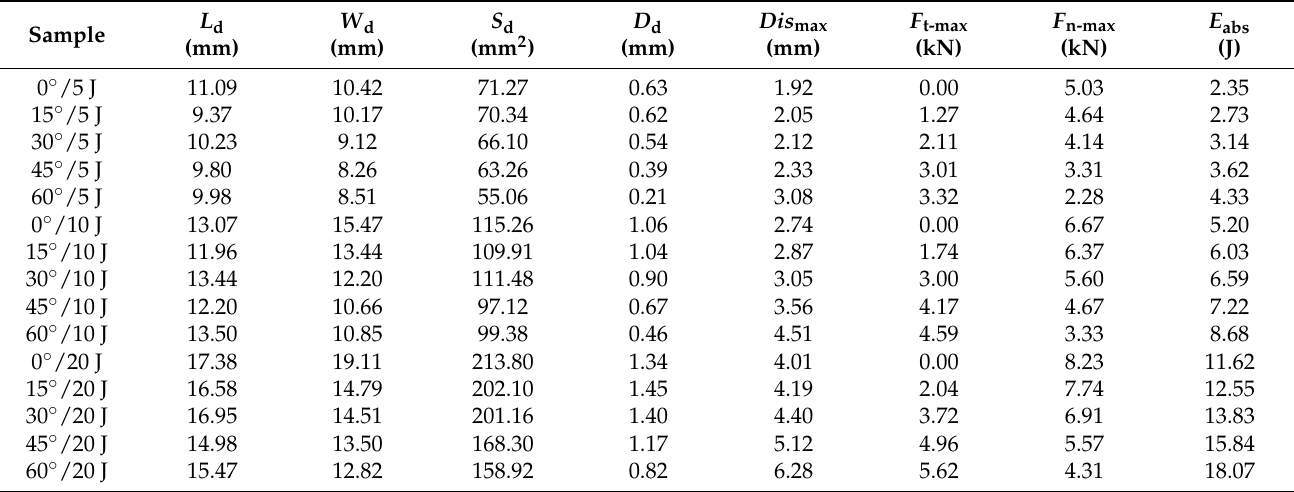
Table 3. Statistics of low-velocity impact numerical